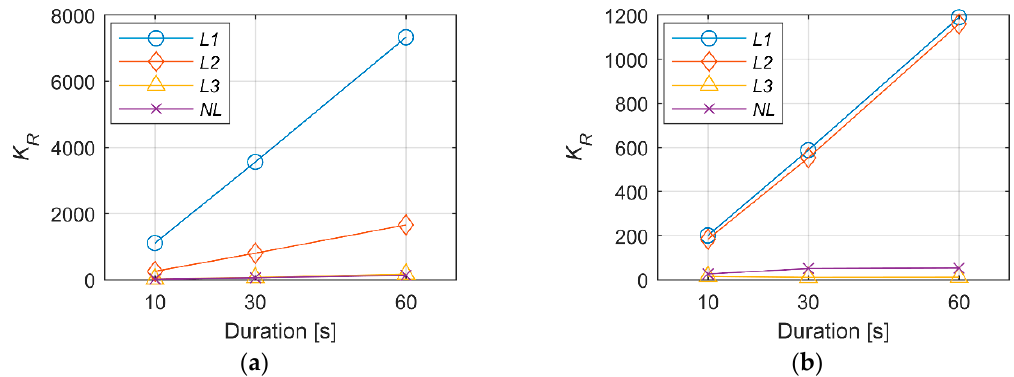
Figure 7. Trend of K R as function of the acquisition duration for Aax signals: ( a ) Test-1; ( b ) Test-2.